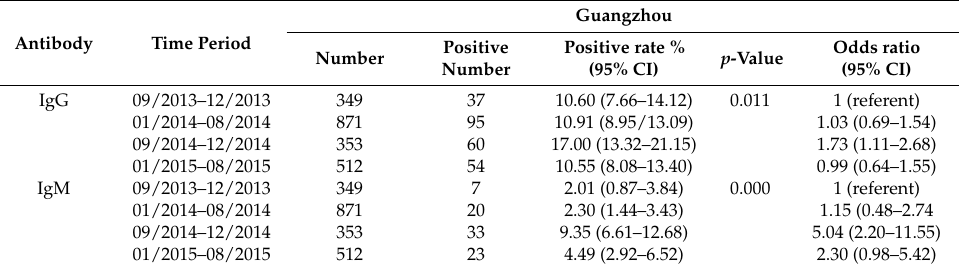
Table 2. Detection results for different time